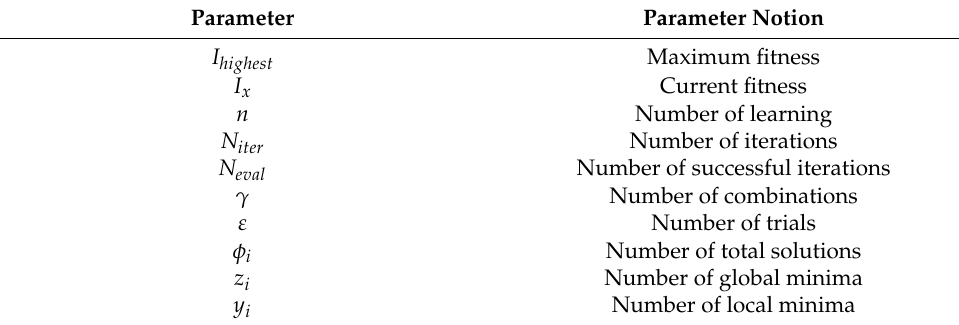
Table 5. List of parameters implicated in the learning and testing